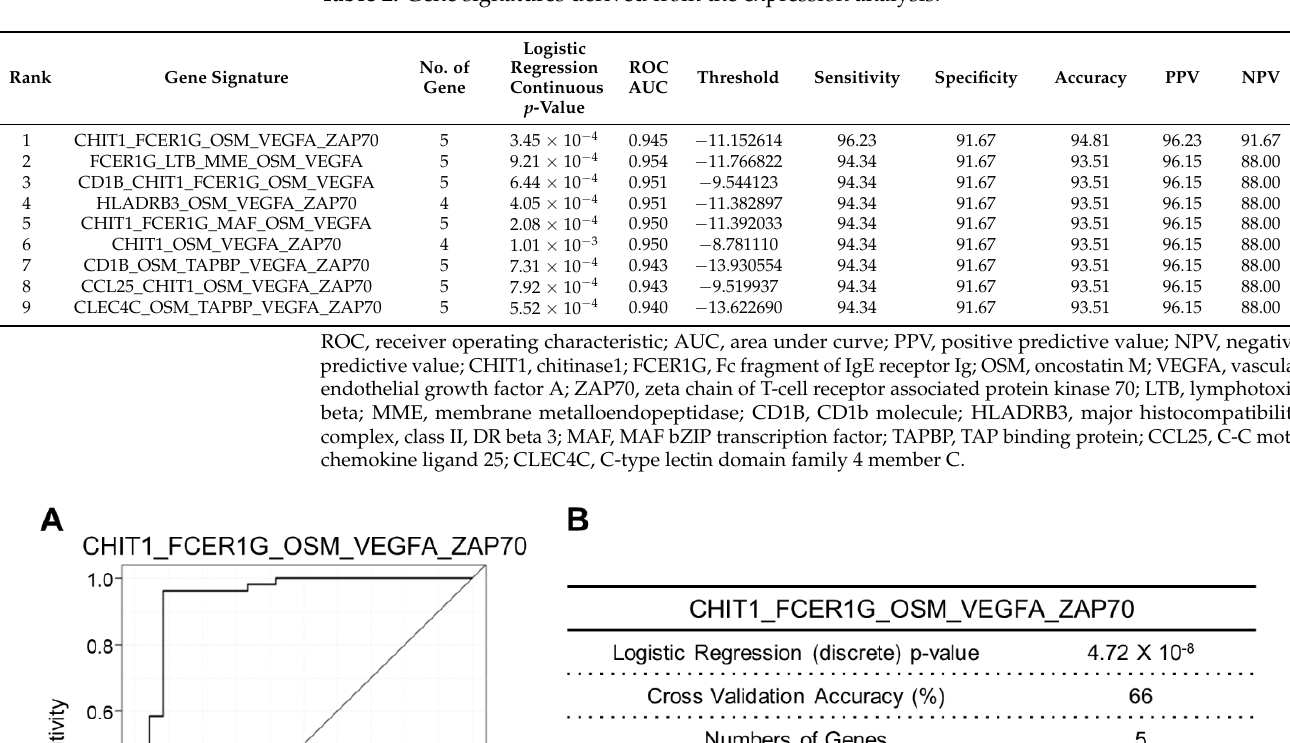
Table 2. Gene signatures derived from the expression analysis.